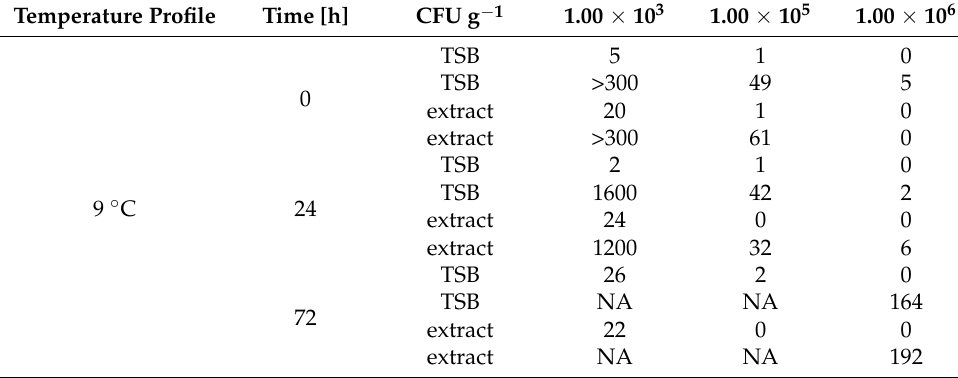
Table A1. The average count of B. subtilis from growth experiments in different temperature profiles in goji berry extract and TSB growth